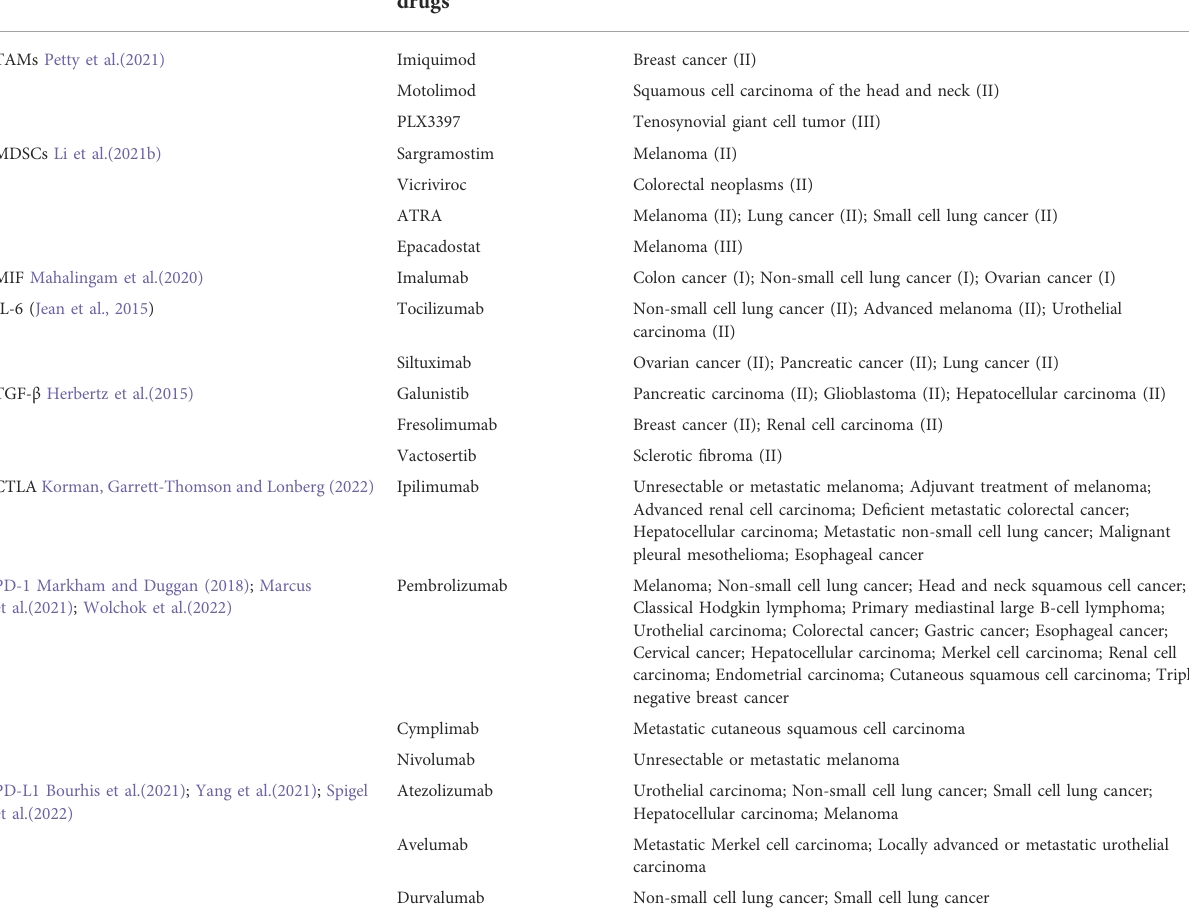
TABLE 3 TME-targeted drugs and immune checkpoint inhibitors (major drugs on the market or in clinical